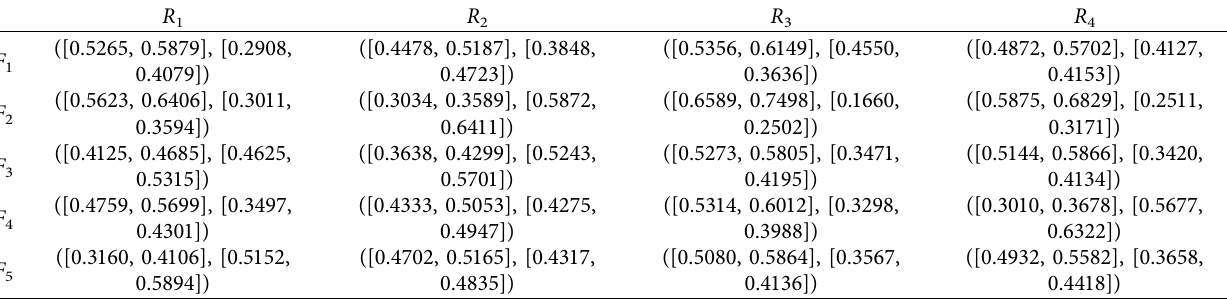
Table 4: The overall matrix with IVIFNs.